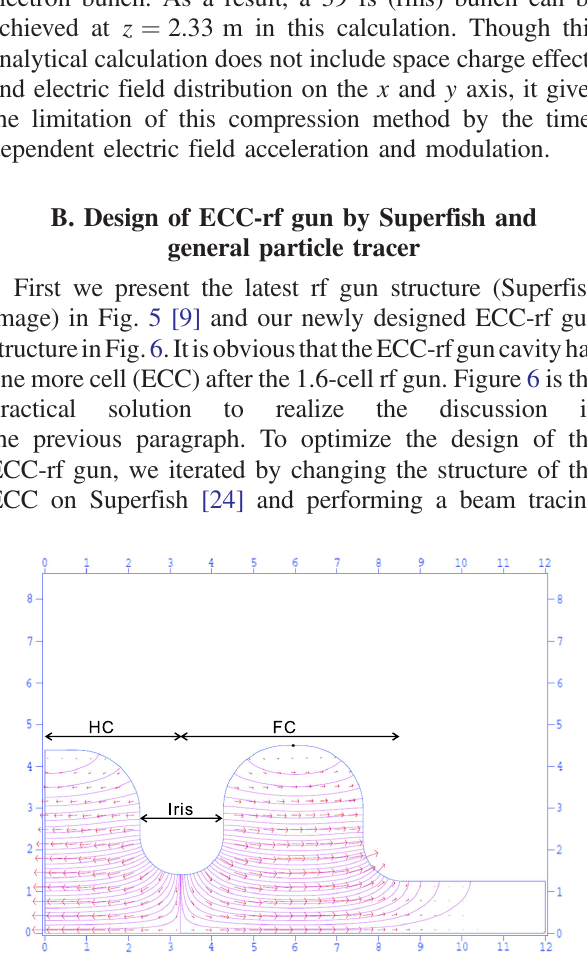
FIG. 5 (color online). Profile of a conventional 1.6-cell rf gun. Designed to obtain a minimum energy spread.